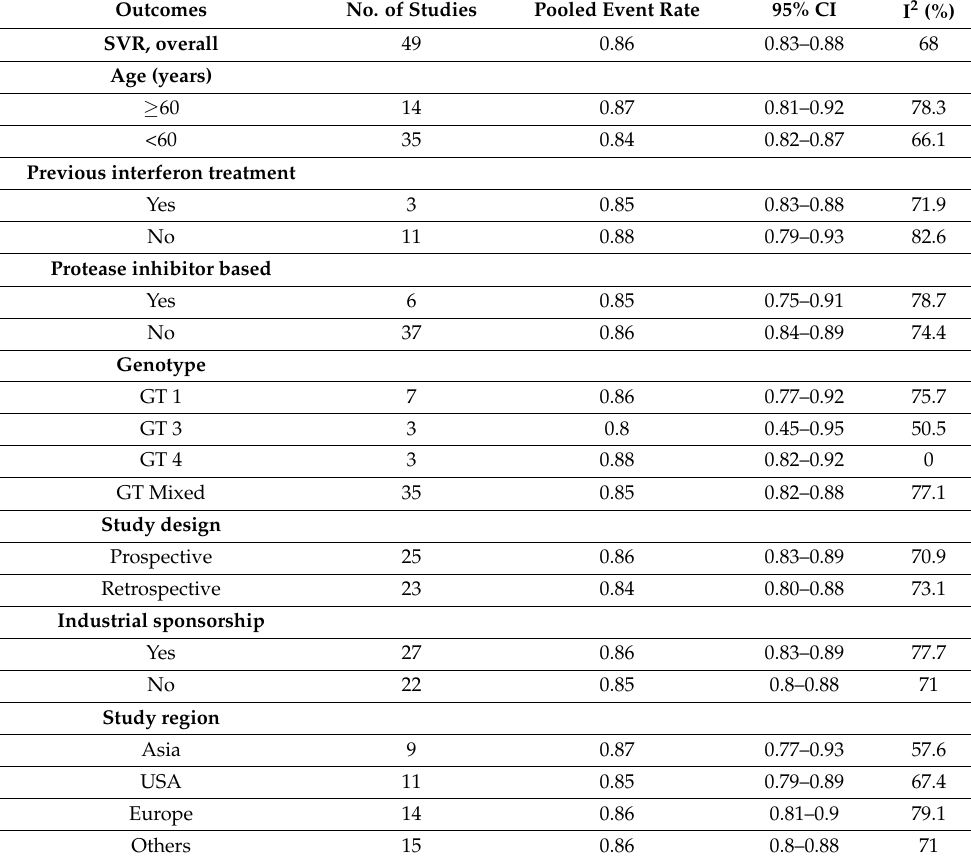
Table 2. Summary of the estimated effect of the sustained virologic response of direct-acting antiviral (DAAs) in decompensated cirrhosis patients with chronic hepatitis C virus (HCV) infection. Outcomes No. of Studies Pooled Event